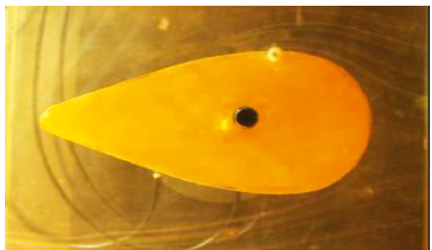
Figure 26: Smoke flow visualization at 0 ° AOA for the 1st module open.